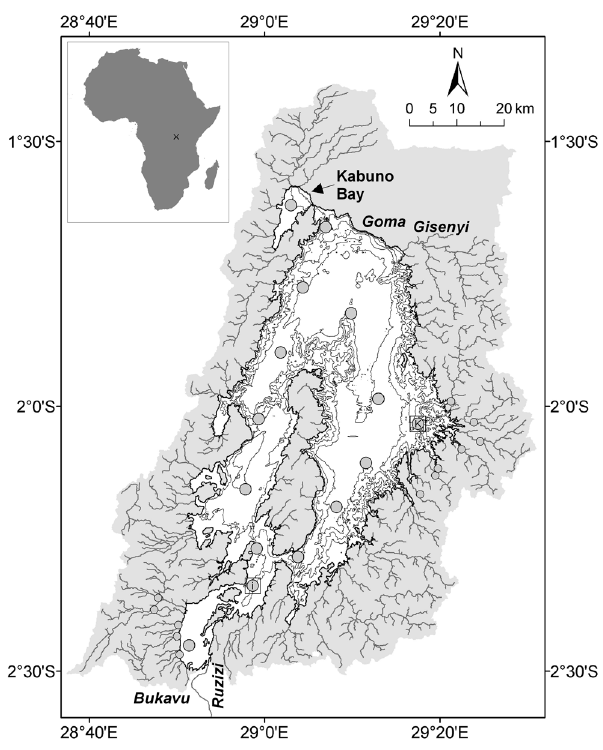
Figure 1. Map of Lake Kivu, showing bathymetry (isobaths at 100 m intervals), catchment area (shaded in grey), rivers, and sampling stations (small circles indicate the rivers). Primary production and bacterial production measurements were made at the stations identified with a square (I = Ishungu; K = Kibuye), adapted from [29].